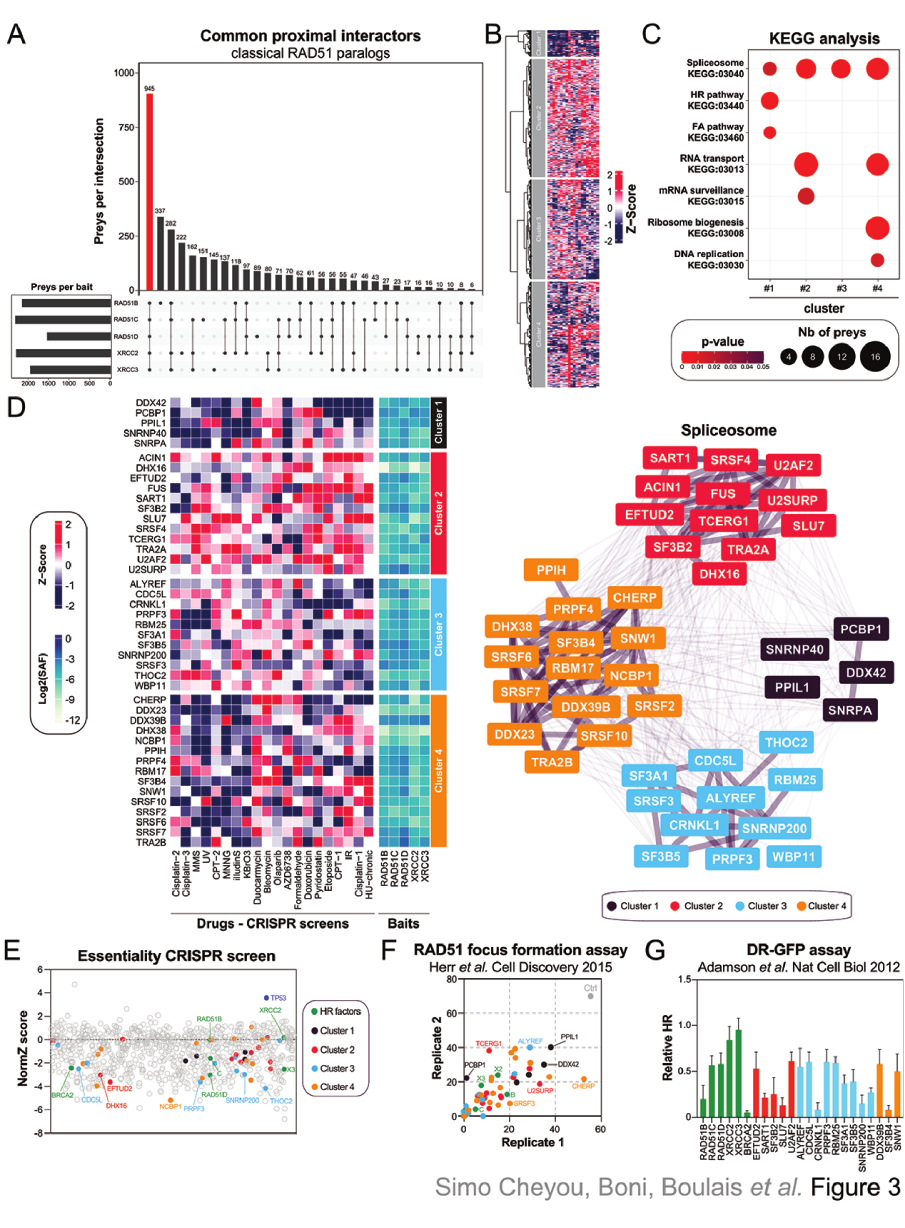
Fig 3. Identification of the spliceosome as a regulator of the classical RAD51 paralogs. (A) Representation of the overlap between the BioID of the different RAD51 paralogs. (B) Heatmap clustering representing the NormZ-scores of the common preys of the RAD51 paralogs in a series of CRISPR screens published by [23] where different genotoxic drugs were tested in RPE1-hTERT cells. (C) Pathway enrichment analysis of the preys that are common to all classical RAD51 paralogs using the KEGG database. Pathways are represented based on their p-value calculated by KEGG algorithm for the 4 different clusters. Each dot is proportional to the number of preys that belong to the indicated pathway. (D) Representation of the different spliceosome factors identified in each cluster. (E) Representation of the CRISPR-based essential screen performed in RPE1-hTERT cells. Each common prey of the classical RAD51 paralogs is represented by its respective NormZ-score. (F) Representation of the percentage of S/G2 U2OS cells transfected with the indicated siRNA and displaying more than 9 IR-induced RAD51 foci as published in [44]. Each replicate is plotted on the x- and y-axis. (G) Representation of the relative HR monitored in U2OS DR-GFP cells transfected with the indicated siRNA as published in [38].